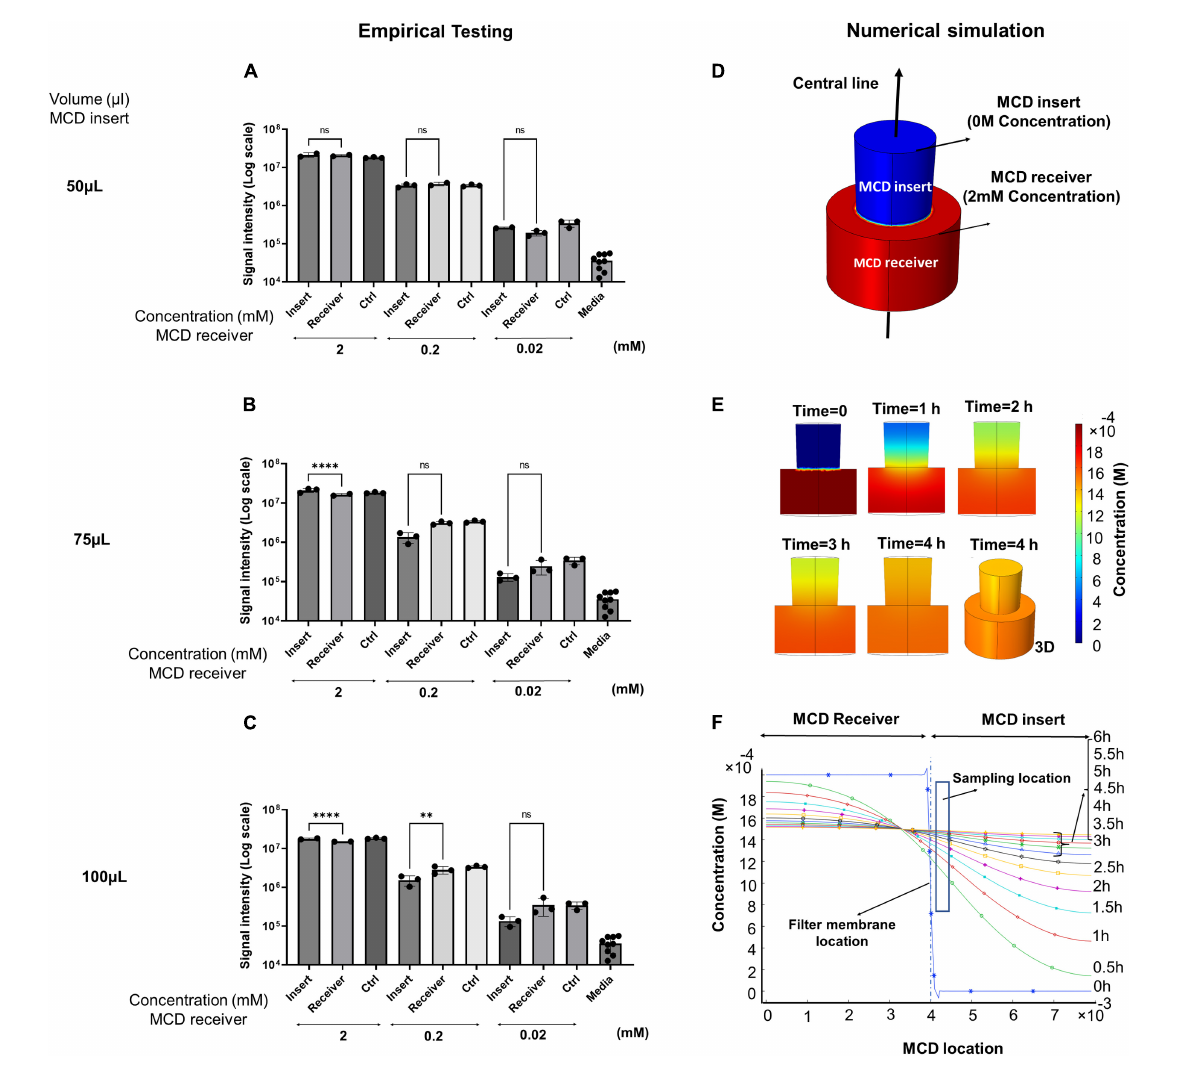
FIGURE2 (A–C) Empirical versus (D–F) simulated diffusion kinetics of succinate dissolved in water in the MCD device. Succinate was added to the MCD receiver (bottom well) and the effects of initial succinate concentration (2, 0.2, and 0.02 mM) and insert aqueous volume (upper well) (50, 75, and 100 µ l) on the final concentrations of succinate observed after 4 h at 37 ◦ C. Succinate signal intensities for MCD insert versus receiver (A) 50 µ l insert aqueous volume, (B) 75 µ l insert aqueous volume, and (C) 100 µ l insert aqueous volume. (D) A 3D model of metabolite concentrations in the MCD was constructed and (E) metabolite diffusion was computed over a 4-h incubation. (F) Metabolite concentrations observed across a vertical transect of sampling points in the MCD crossing from the bottom of the receiver, through the membrane, and to the top of the insert are shown across a time point ranging from 0 to 6 h. For bar graphs, ∗∗ p < 0.01 and ∗∗∗∗ p <